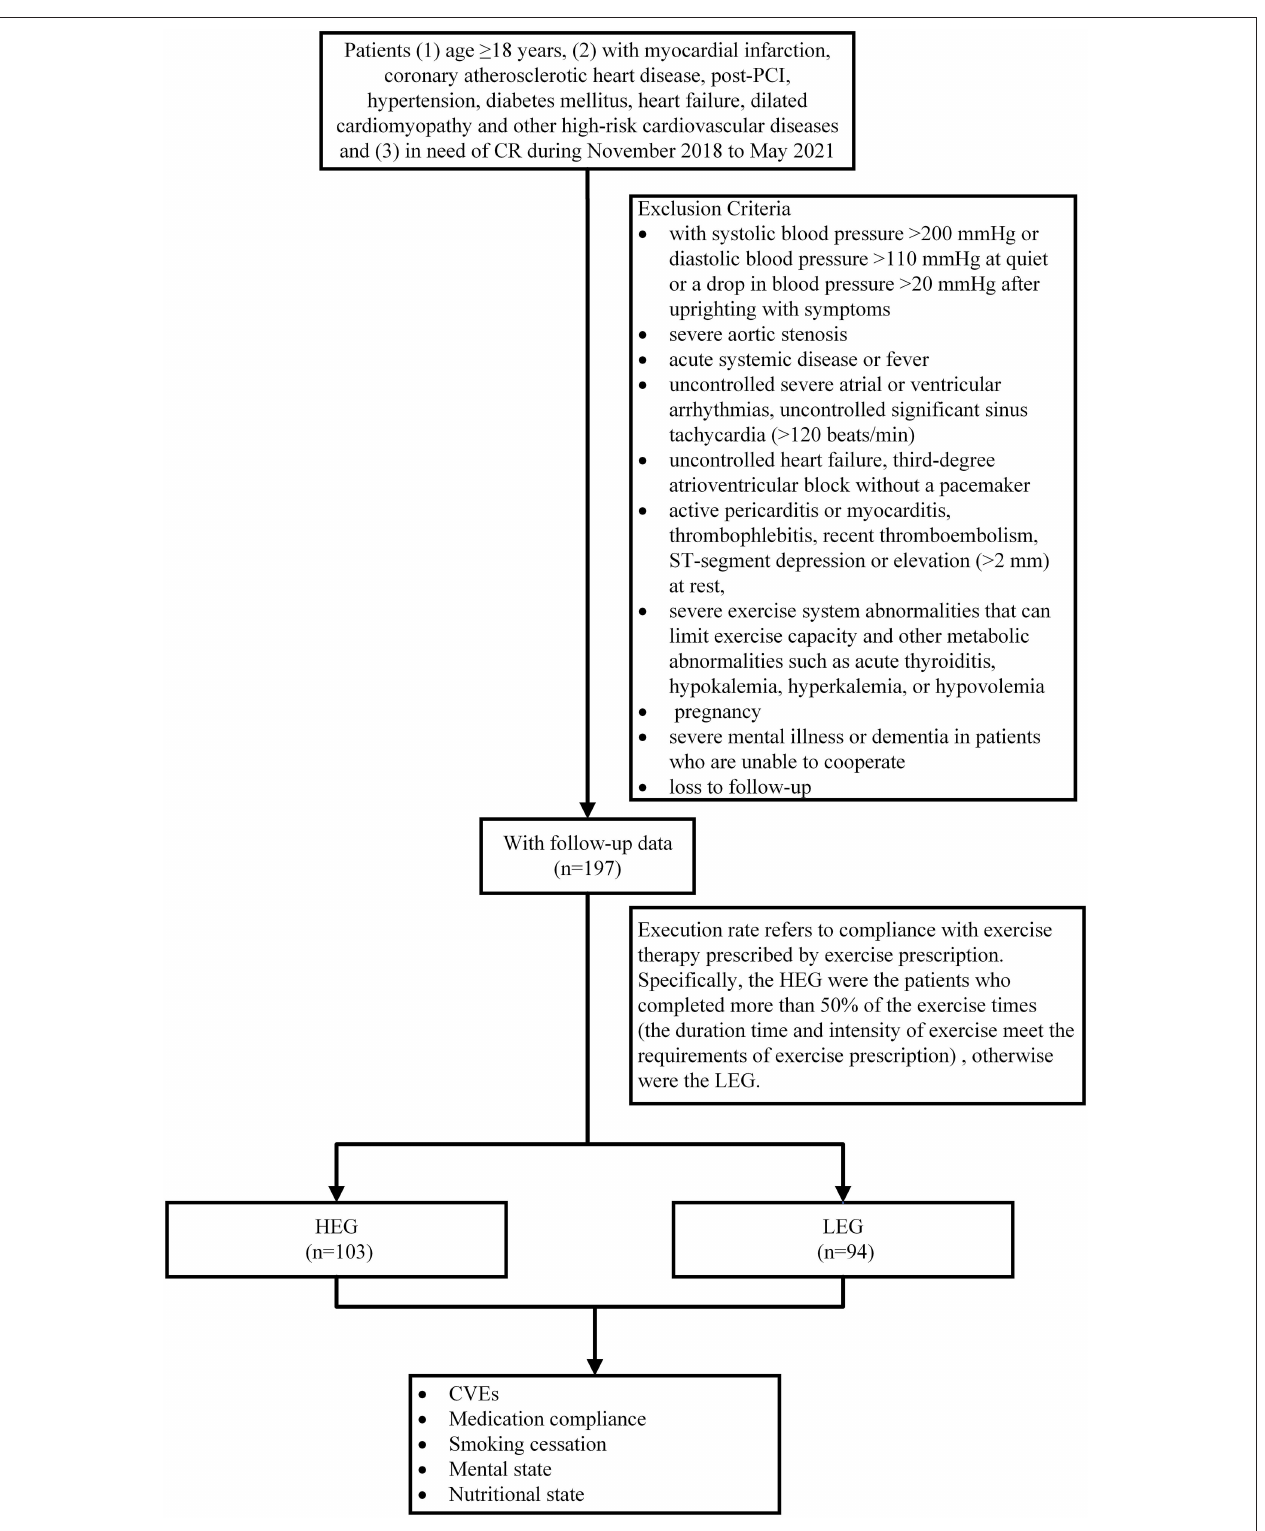
FIGURE 1 | Study design flowchart. PCI, percutaneous coronary interventions; CR, cardiac rehabilitation; HEG, high execution group; LEG, low execution group; CVEs, cardiovascular diseases.